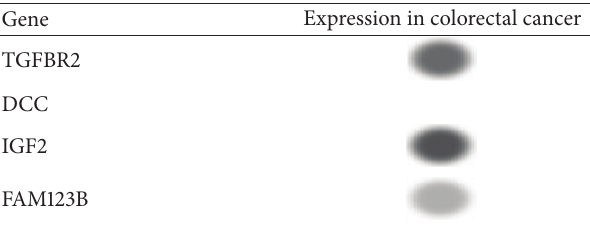
Table 2: Expression profiles of genes in colorectal cancer, retrieved from